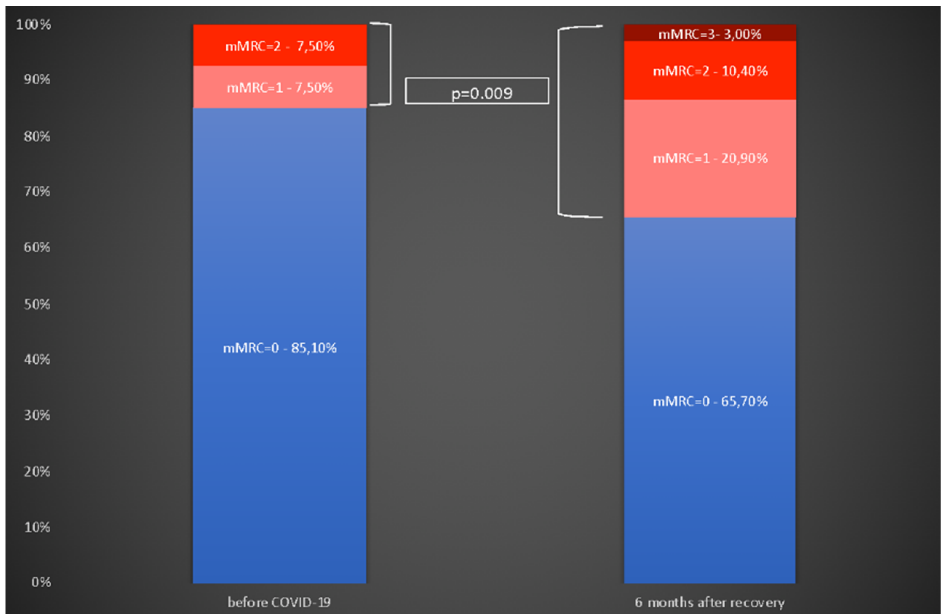
Figure 3. Self-reported dyspnea on exertion (mMRC questionnaire) before COVID-19 and 6 months after recovery. mMRC = 0 (no breathlessness), 1 (breathless when hurrying or walking up a hill), 2 (breathless when walking slower than people of same age or has to stop when walking), 3 (breath- lessness stops walking after ∼ 100 m or a few minutes).